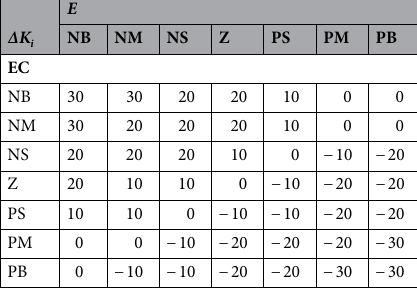
Table 3. Fuzzy control rules of Δ K i .